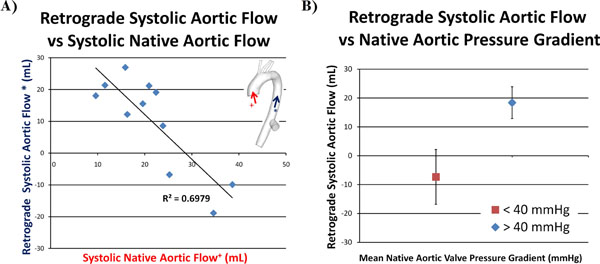
A) Retrograde systolic aortic blood flow in the descending aorta is inversely correlated to systolic native aortic flow. B) Patients with pre-surgery aortic valve pressure gradients greater than 40 mmHg will likely have retrograde aortic blood flow.